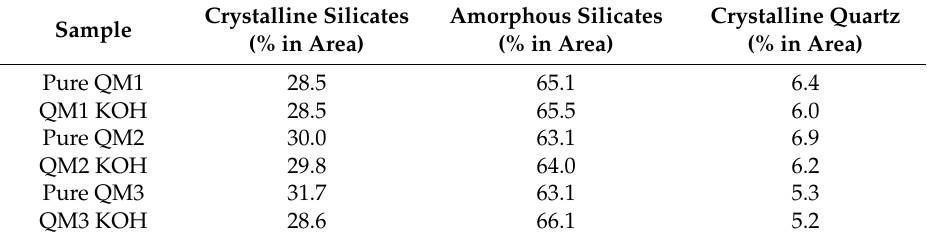
Table 4. Quantification of crystalline and amorphous silicate sites obtained by